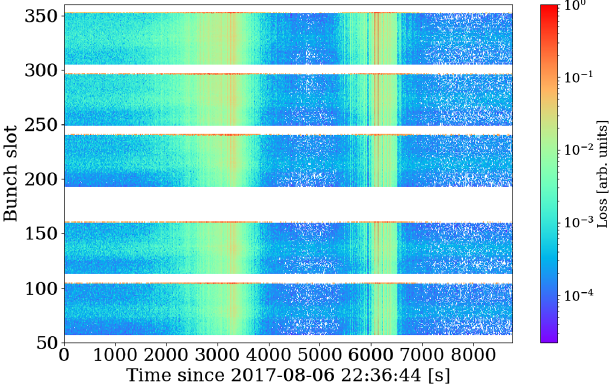
FIG. 4. Bunch-by-bunch loss from the dBLM monitor, re- corded by acquisition mode 1 during the test in fill 6052 reported in Table